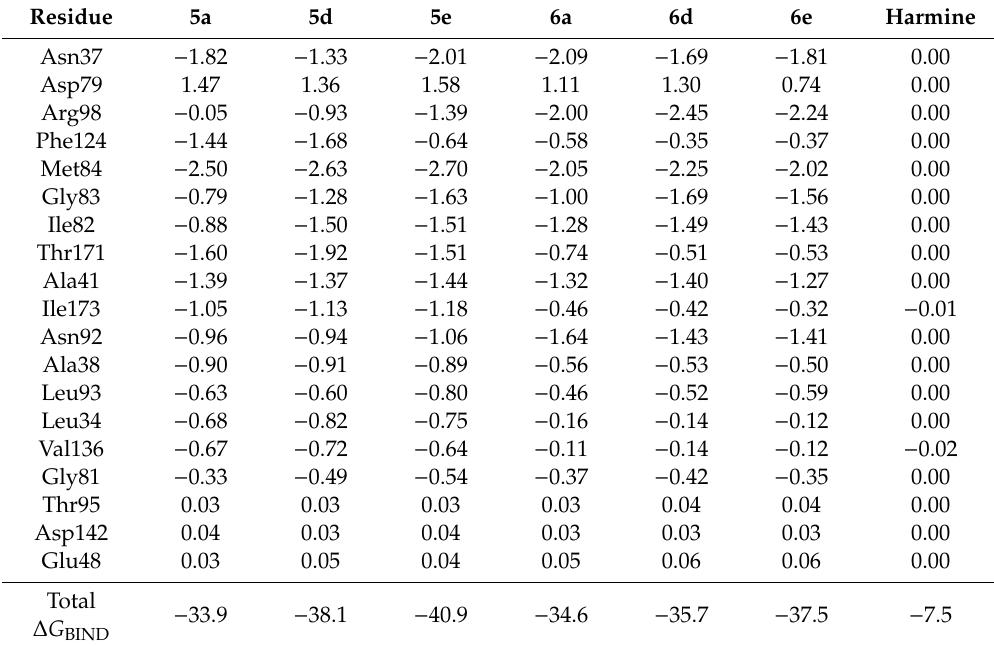
Table 2. Calculated total binding free energies ( ∆ G BIND ) from molecular dynamics trajectories using MM-GBSA approach, and their decomposition on a per-residue basis for selected derivatives. 1 Data for harmines are taken from